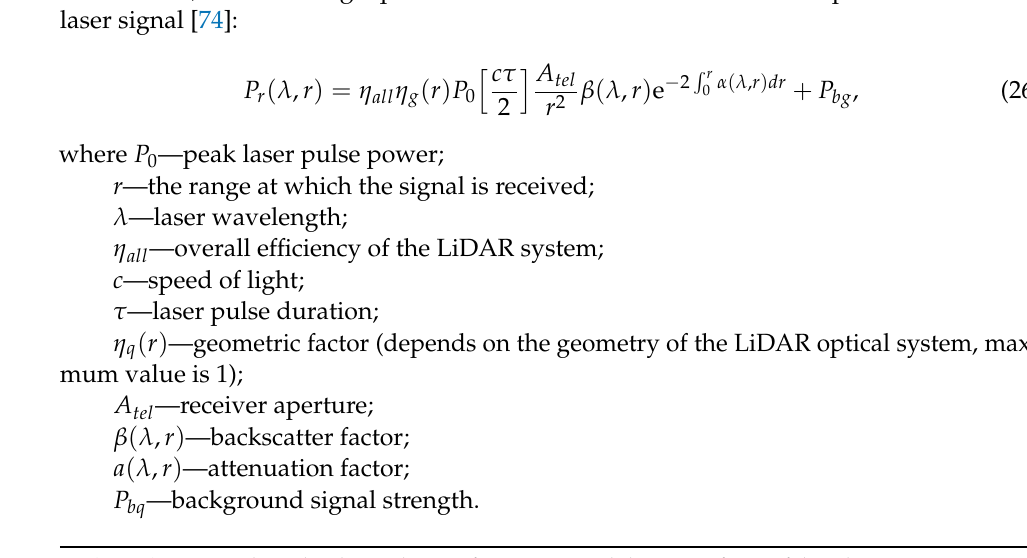
Algorithm 1. Finding the dependence of correct signal detection from “false